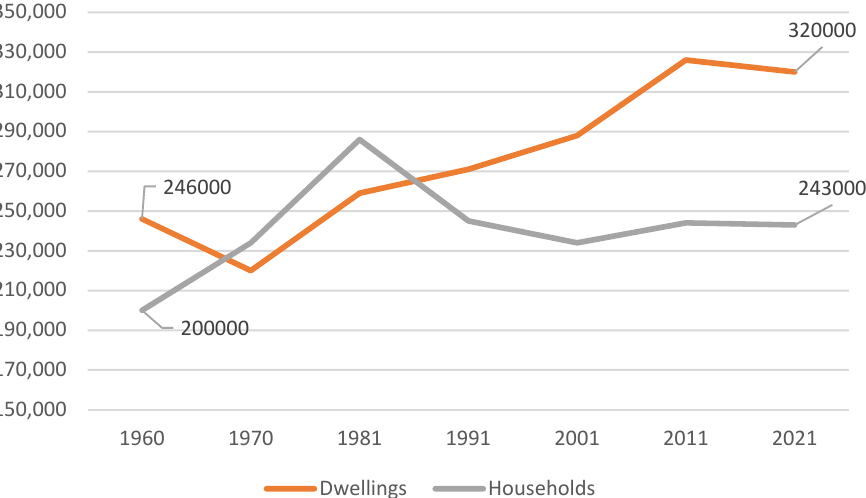
Figure 1. Number of dwellings and households in the city of Lisbon. Source (CML 2022).